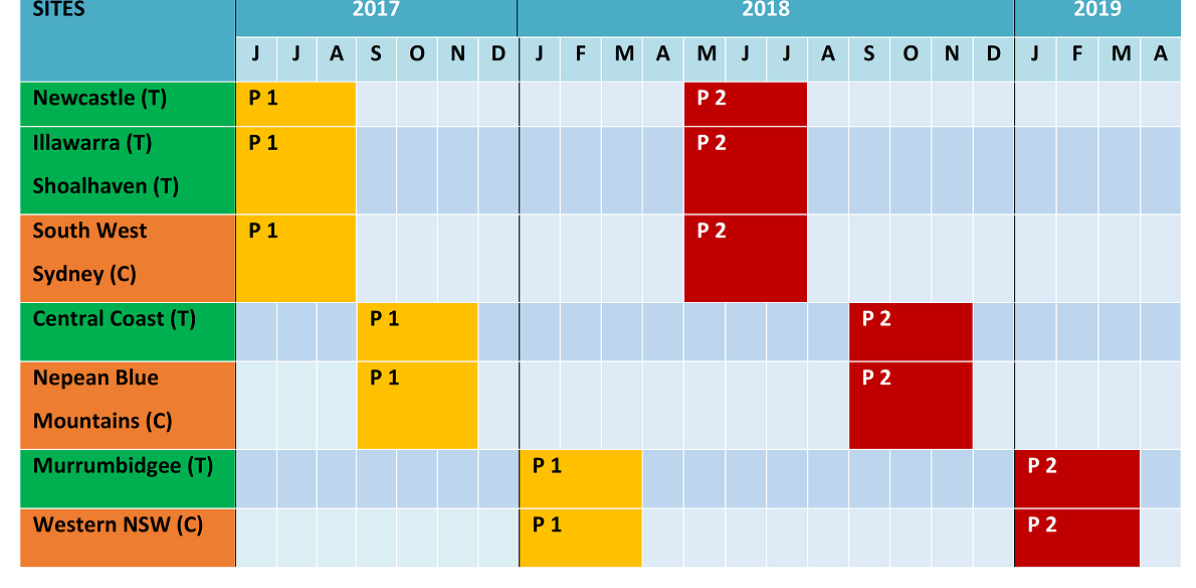
Figure 1. Baseline recruitment for Panel 1 and Panel 2 trial (T) and control (C)